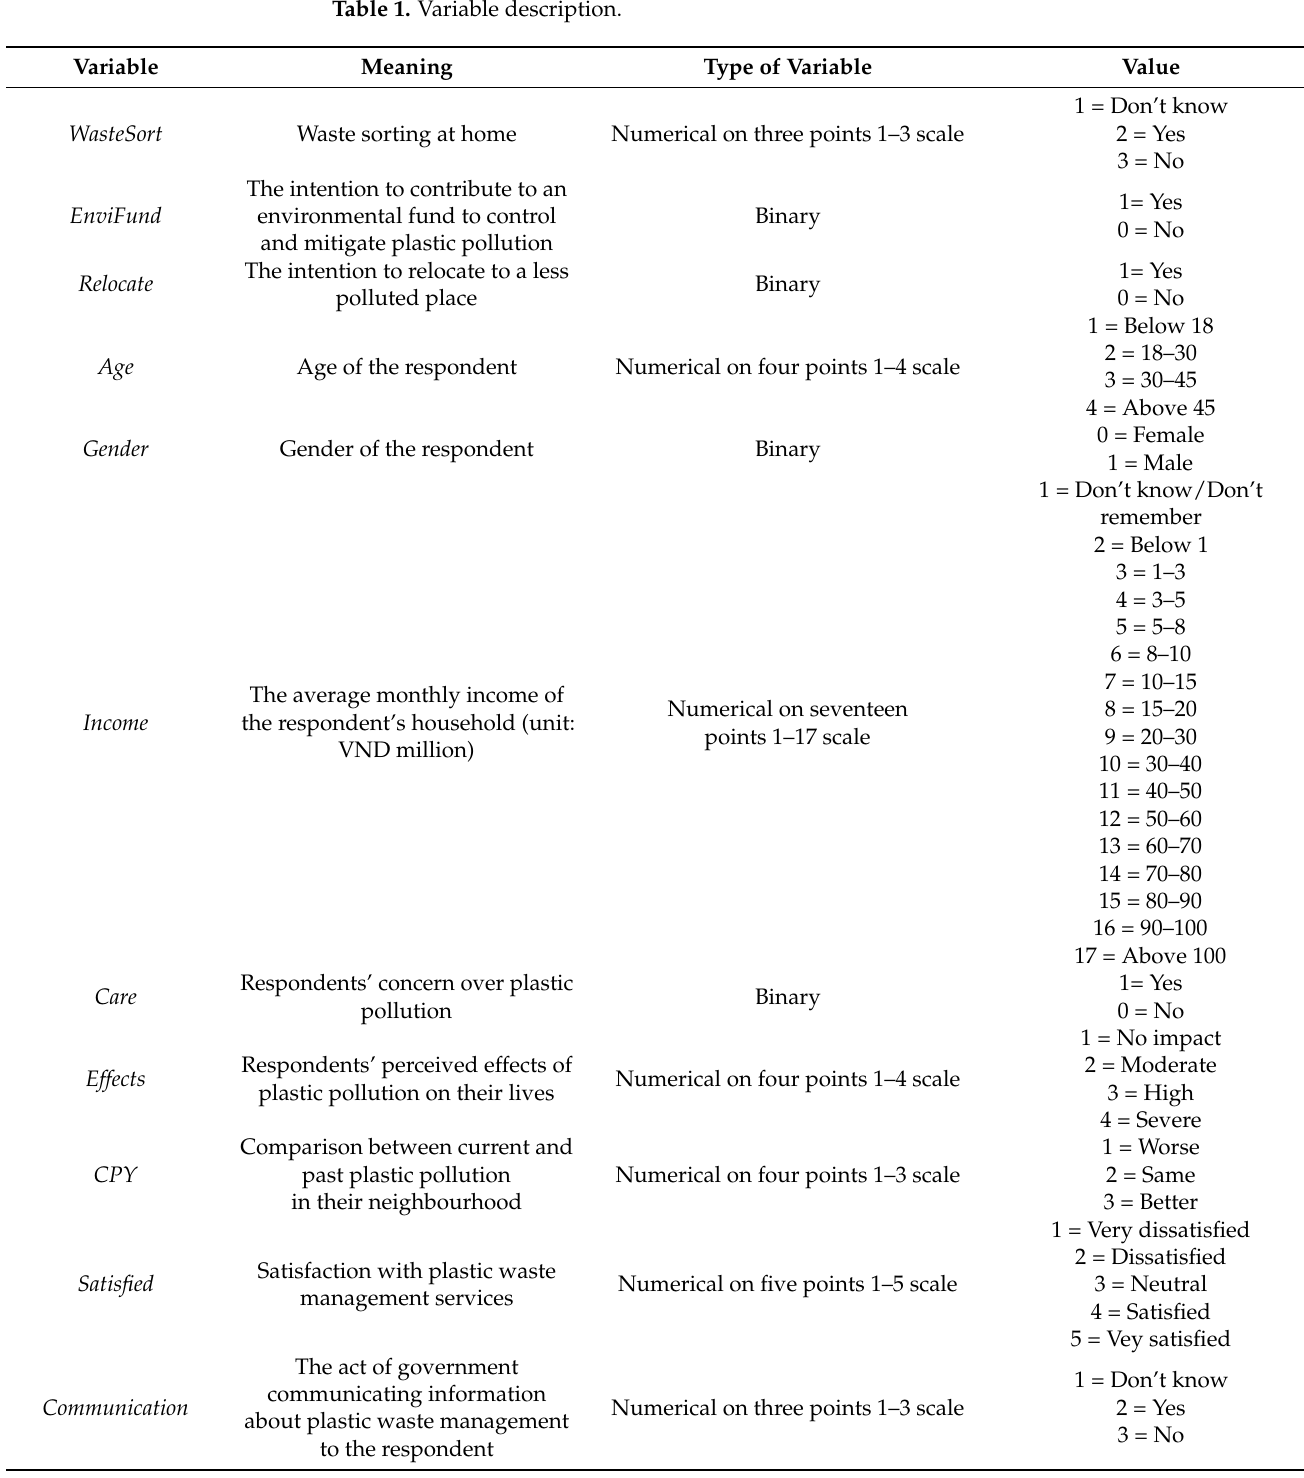
Table 1. Variable